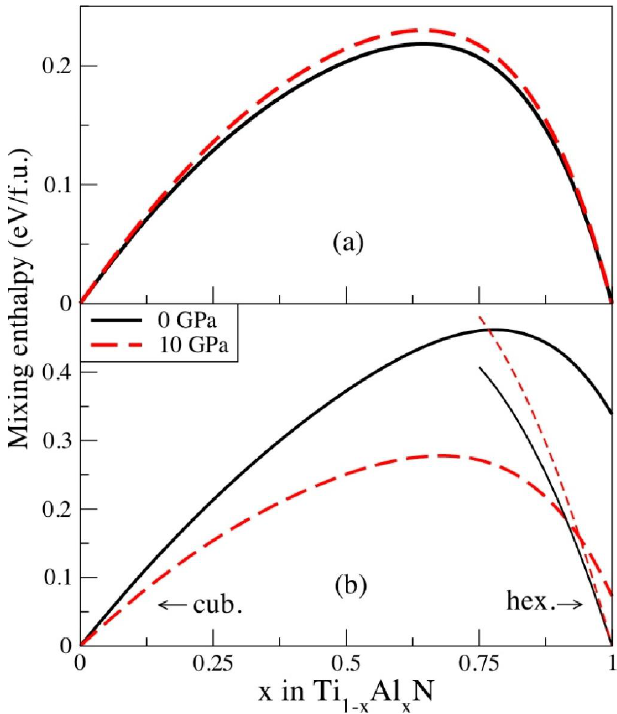
Figure 3. ( a ) Isostructural cubic mixing enthalpy of Ti P = 10 GPa; ( b ) Mixing enthalpy of cubic rock salt (thick lines) and hexagonal wurtzite (thin lines) Ti Al N as a function of AlN fraction x at pressures P = 0 GPa and P = 10 GPa, 1−x x relative to cubic TiN and hexagonal